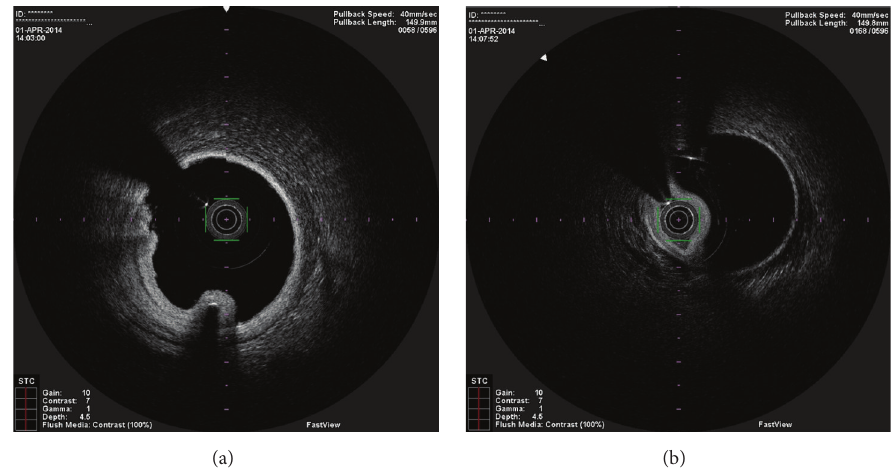
Figure 3: OCT image showing one guidewire in the false lumen and the other in the true lumen.